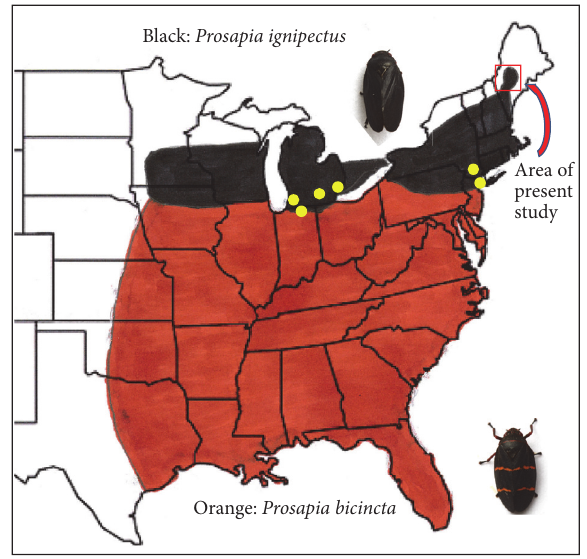
Figure 1: Approximate species ranges of Prosapia ignipectus (in black) and Prosapia bicincta (in orange). The populations examined in this study lie in the far northeastern portion of the P. ignipectus range in the area of the state of Maine outlined in red (see Figure 6). Yellow dots represent the occurrence of populations with mixed color forms, nominally all P. ignipectus , towards the southern part of the P. ignipectus range (see text for